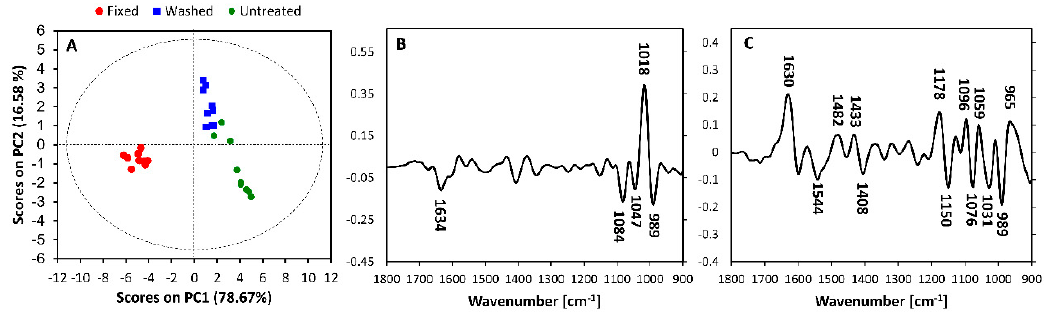
Figure 2. Principal component analysis (PCA) of Principal Components (PC) PC1 versus PC2 with ( A ) scores plot and loadings plot for ( B ) PC1 and ( C ) PC2 for spectra from Candida glabrata subjected to the three different preparation methods. PCA and PC1 loadings plots showing the sample preparation dependent discrimination for all Candida spp. used in this study are presented in Supplementary Materials (S1).